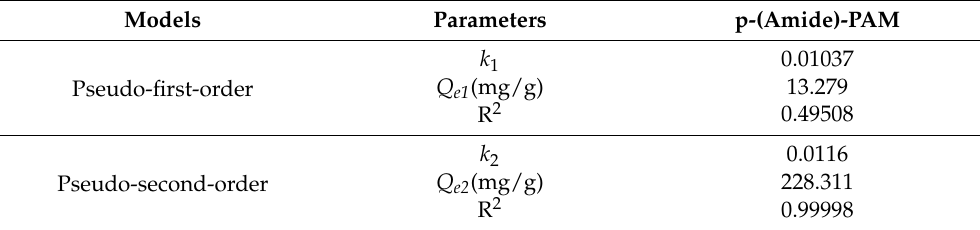
Figure 7. Adsorption kinetics of p-(Amide)-PAM for ReO 4 − ( a ): fitting pseudo-first-order kinetic model ( b ) and fitting pseudo-second-order kinetic model ( c ). The dosage of the absorbent was 1 g/L, pH was 5.5, time was 0–240 min, initial concentration of ReO 4 − was 300 mg/L, and the temperature was 298.15 K. Table 4. Fitting parameters of the pseudo-first-order model and pseudo-second-order model .